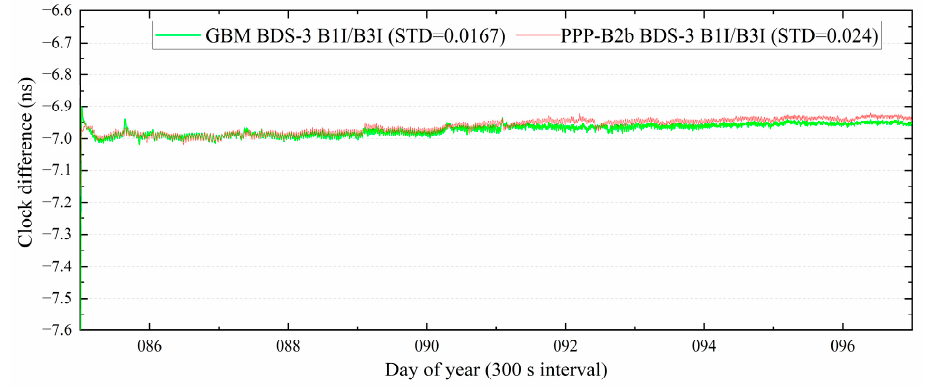
Figure 12. CCD time comparison using the PPP-B2b product and the GBM product between NTTS and NT07.